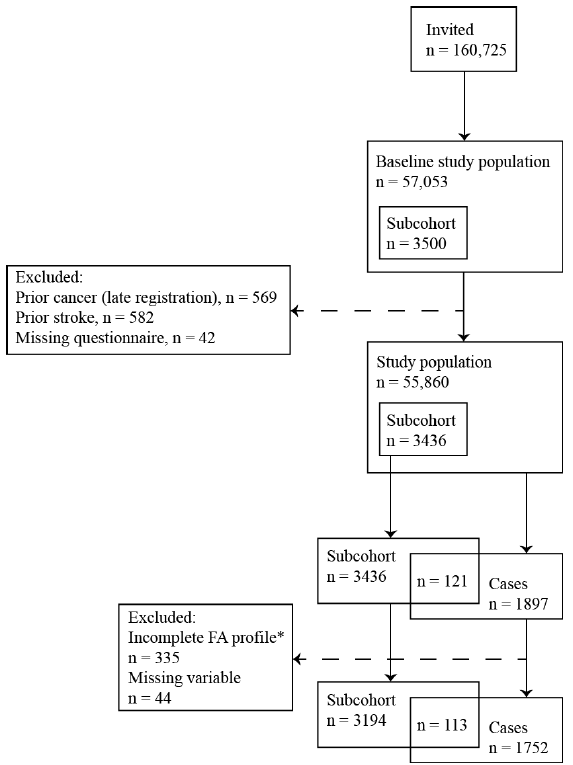
Figure 1. Study flowchart illustrating the cohort size and exclusion criteria applied and hence the case and subcohort size as well as the number of cases within the subcohort. FA = fatty acid. * An incomplete fatty acid profile was defined as a fatty acid content <95% of the total fatty acid composition.